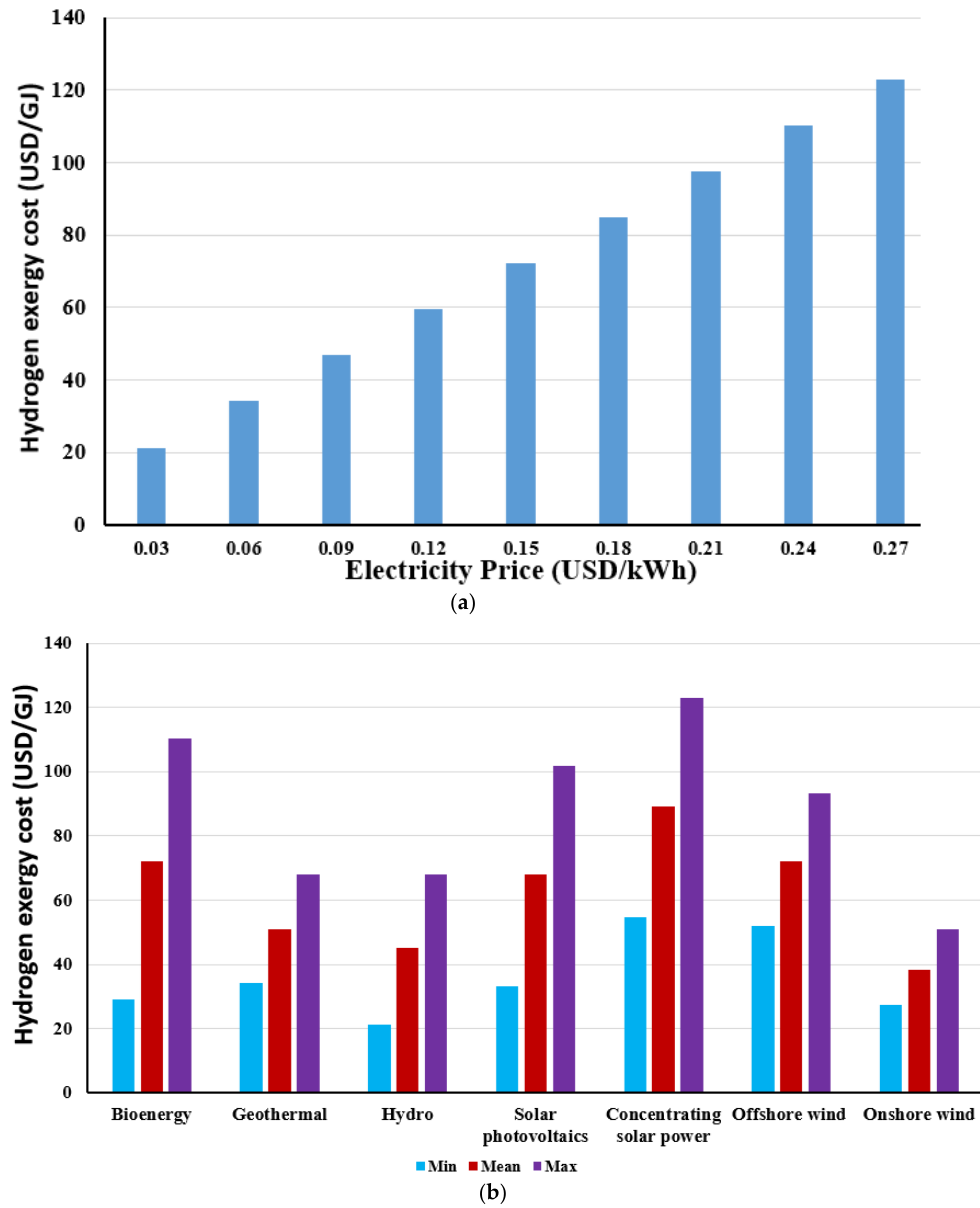
Figure 12. Hydrogen exergy cost with different: ( a ) electricity prices; and ( b ) electricity generated using various renewable energy resources.